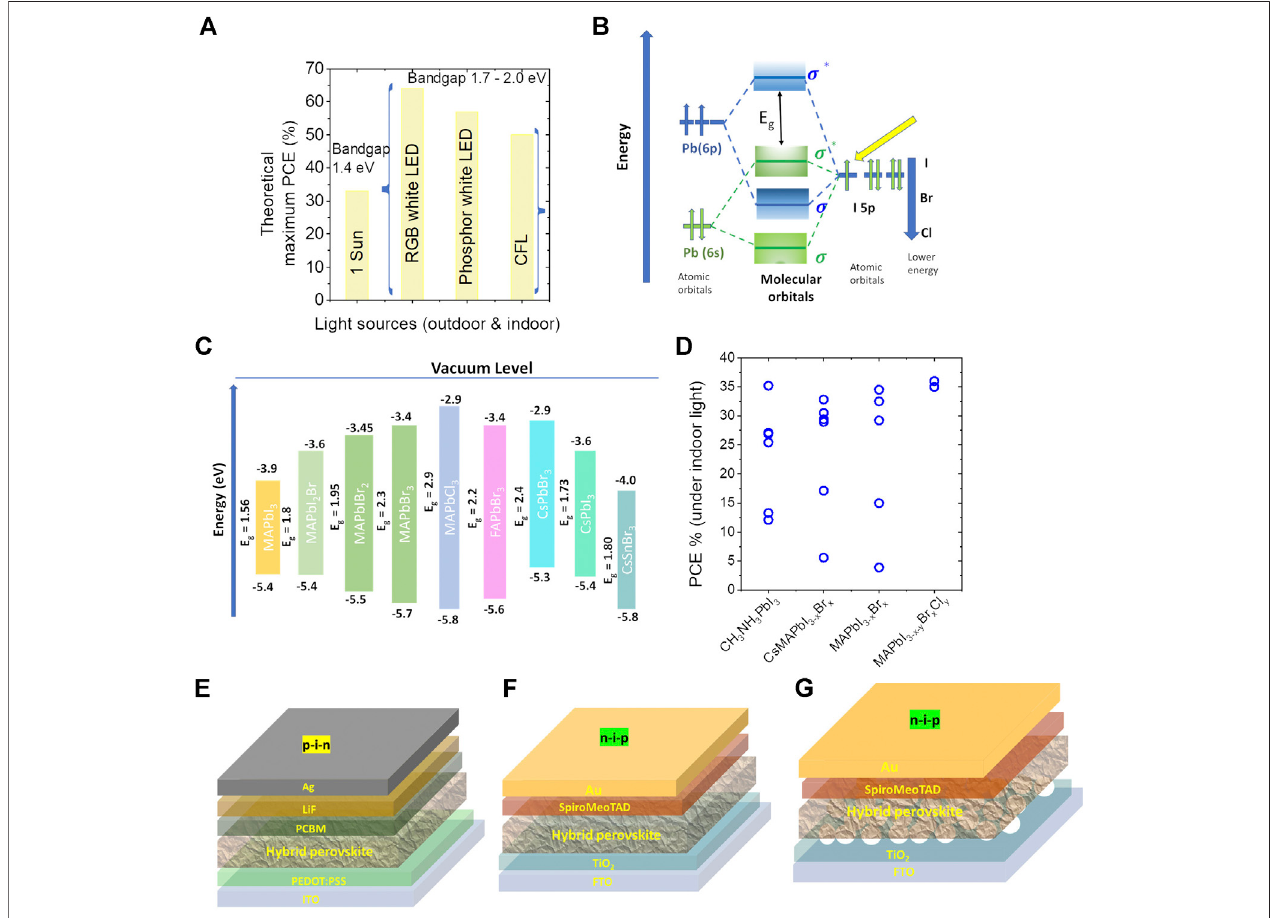
FIGURE2|(A) Maximumtheoreticalef fi ciencyofIPVsasafunctionofbandgap, (B) electronicbandstructureofhalideperovskites, (C) sometypicalwide-bandgap halide perovskites, and (D) power conversion ef fi ciency of halide perovskite indoor photovoltaic devices as a function of different composition. Different photovoltaic device architectures, (E) planar p-i-n , (F) planar n-i-p , and (G) mesoporous n-i-p